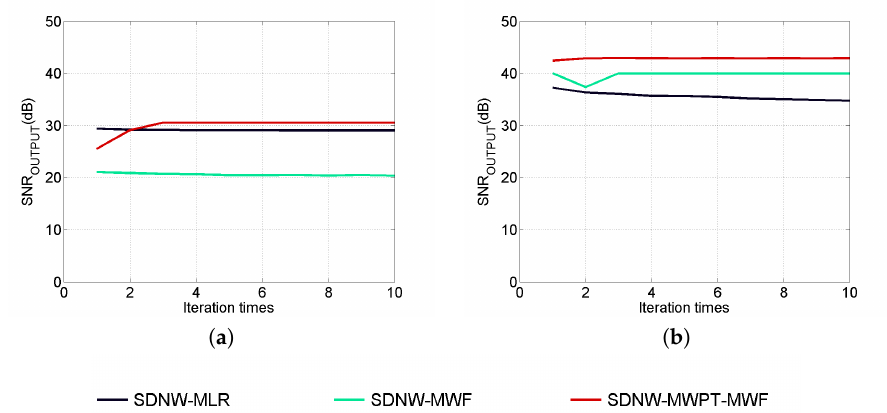
Figure 10. Evolution of SNR OUTPUT with iteration times according to different values of SNR INPUT :